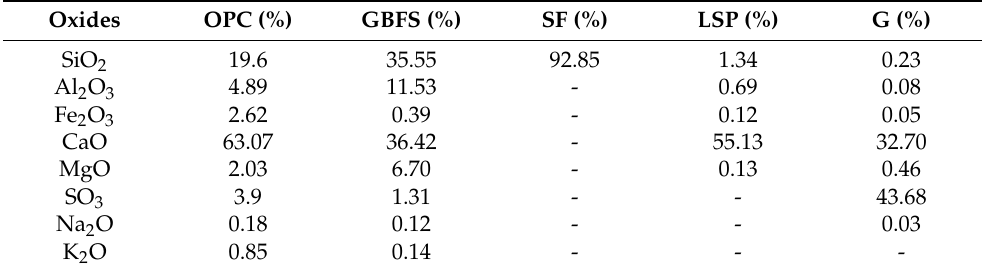
Table 1. Chemical compositions of the binder materials.